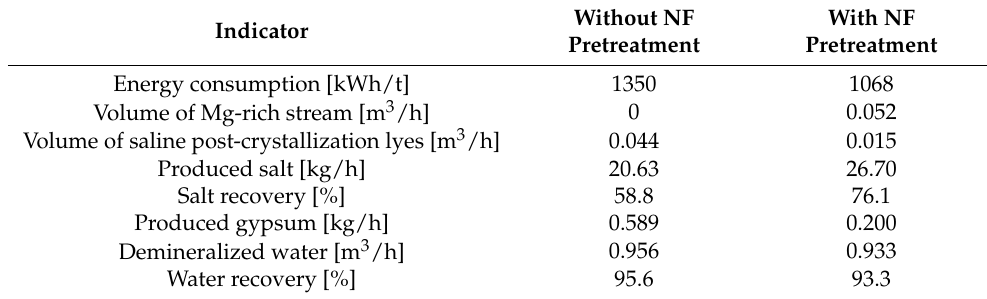
Table 3. Comparison of performance indicators between the current D˛ebie´nsko operation (without NF pretreatment) and the operation with NF pretreatment. Without Indicator